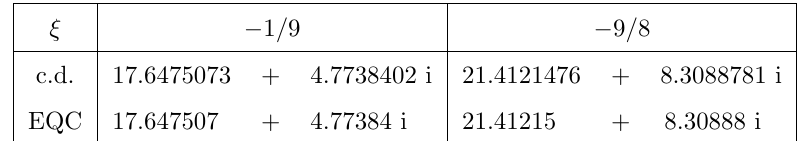
Table 4 . Value of e E 0 for the operator (2.67) and ~ = 2 (cid:25) , for (cid:24) =